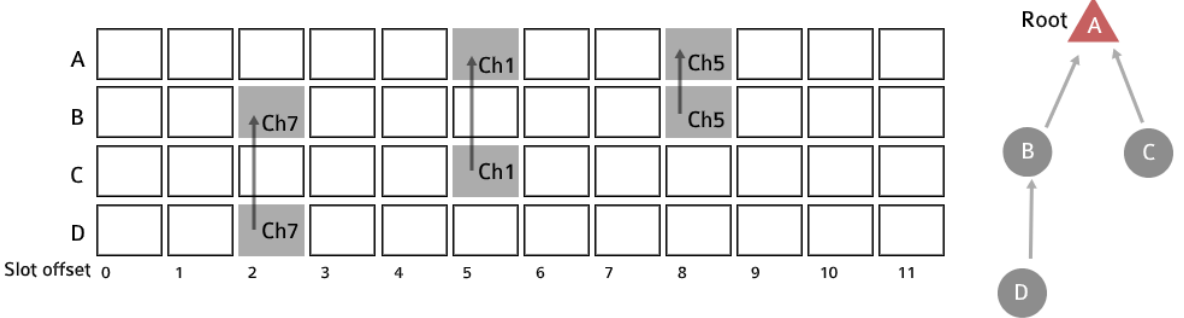
Figure 2. A typical TSCH slotframe for Motes A–D, using a uniform slot duration and single physical layer at a fixed bitrate. Each node allocates a specific slot offset and channel offset for transmissions to its